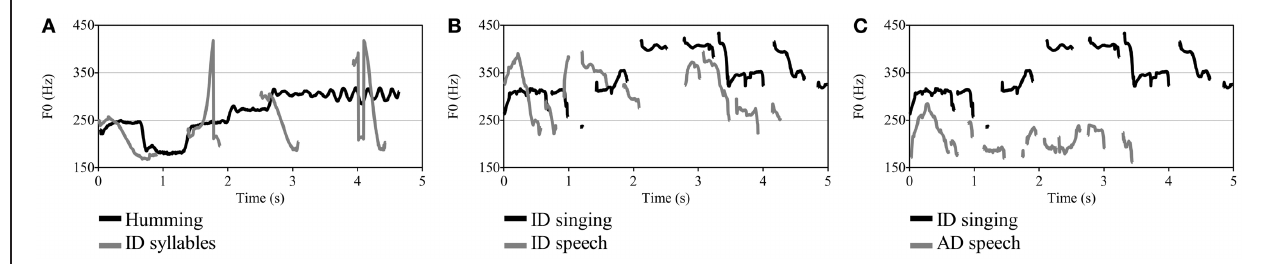
FIGURE 1 | Fundamental frequency (F0) contours of 5-s excerpts from each sound type. (A) hummed lullaby (Chilean) and syllable sequence, (B) ID sung and spoken lyrics of Turkish play song, (C) ID sung and AD spoken lyrics of Turkish play song.